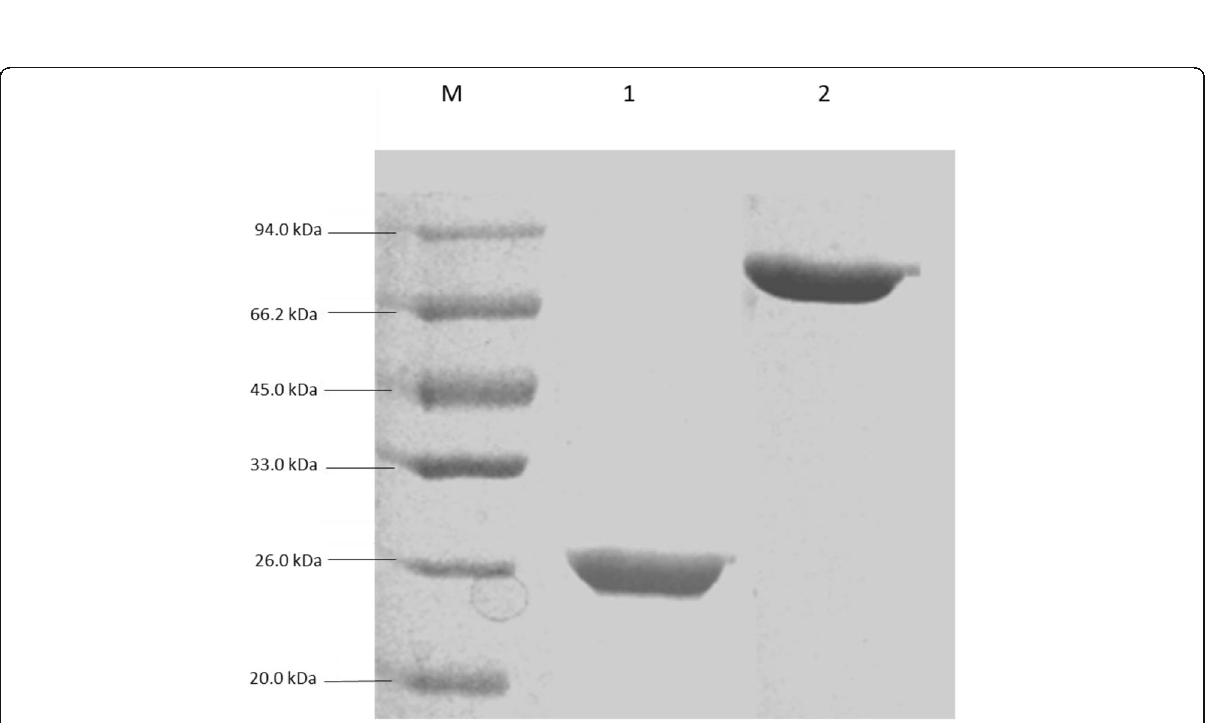
Fig. 4 The activity of the OS6 protein was obtained. In order to obtain the Os6 protein, the protein was extracted from protein expression strain and seperated by protein SDS-PAGE